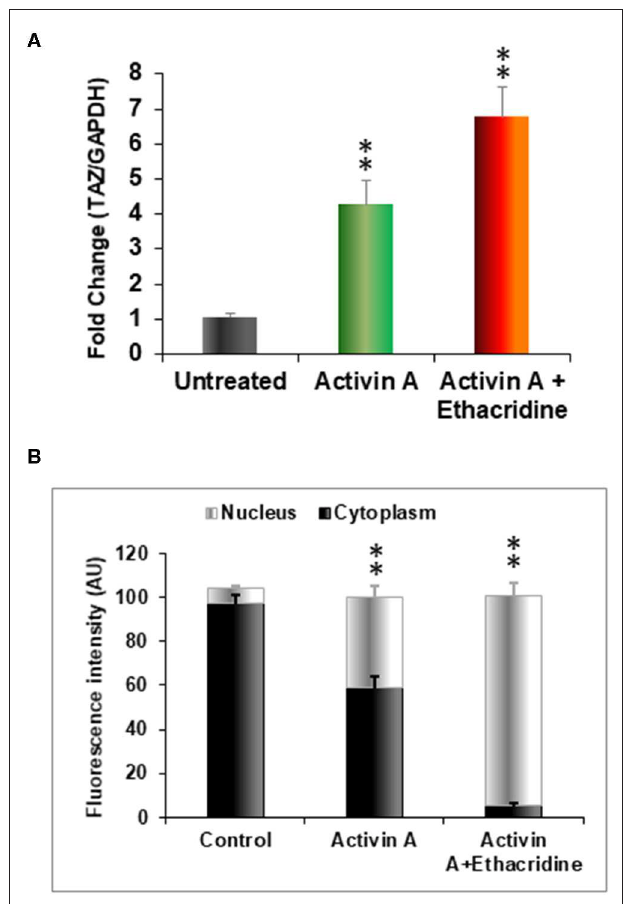
FIGURE 5 | Effects of ethacridine on TAZ in human iPSCs (LF cells). (A) Enhancement of TAZ in ethacridine treated activin A derived endoderm from human iPSCs (LF cells). Data were expressed as mean ± SEM and represent one of three separate experiments. ** p < 0.01 ethacridine treated activin A derived endoderm in comparison with untreated or activin A treated alone. Data were analyzed by analysis of variance (ANOVA) followed by the Student-Newman-Keuls test. (B) The relative abundances of TAZ in cells in cytoplasm and nucleus was quantified from sets of 10 cells per image and expressed as arbitrary units of Fluorescence Intensity (FI). Data are means ± SEM of three independent experiments. ** P < 0.01 comparison among different groups. Data were analyzed by analysis of variance (ANOVA) followed by the Student-Newman-Keuls